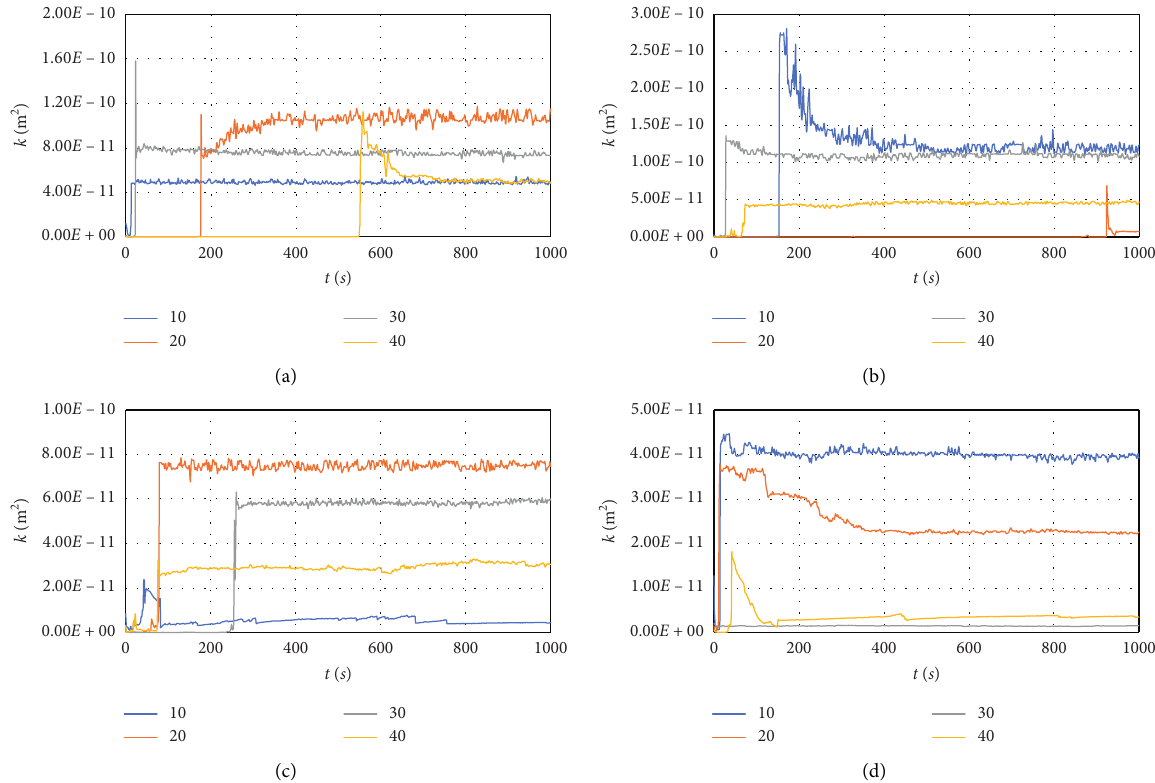
Figure 4: The permeability of samples with different gradation under different compaction levels varied with time. (a) n � 0.4. (b) n � 0.5. (c) n � 0.6. (d) n �